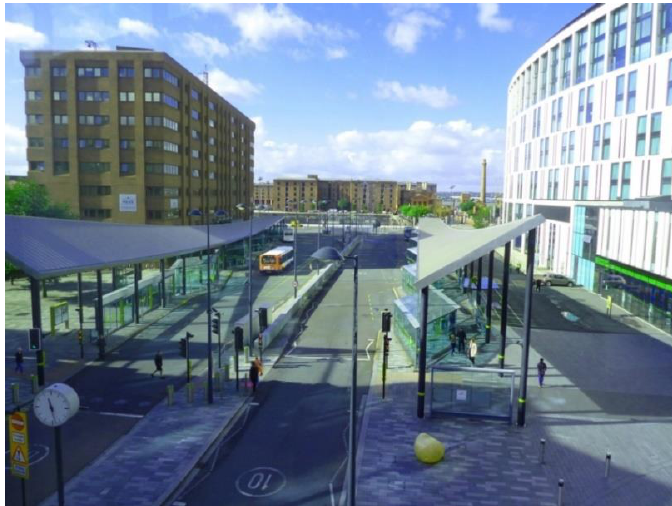
Figure 8. Example of bus stations hindering respect and social inclusion (P1) (Liverpool One bus station). Both photos were taken by the same participant, who used photographs and their associated meanings to illustrate the concept of accessibility as an important dimension of social inclusion in the urban context.